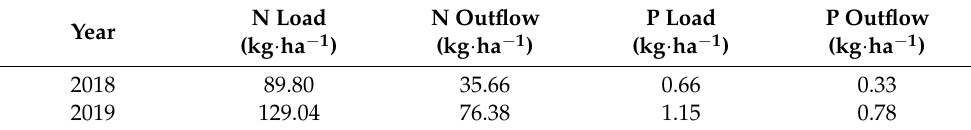
Table 2. Nitrogen and phosphorus load and outflow (kg · ha − 1 ) during two growing periods.